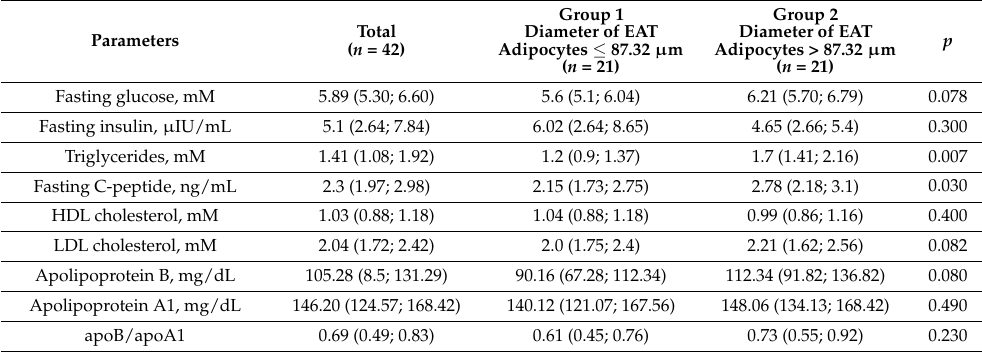
Table 3. Parameters of glucose/insulin metabolism and lipid transport blood function depending on the mean size of adipocytes.